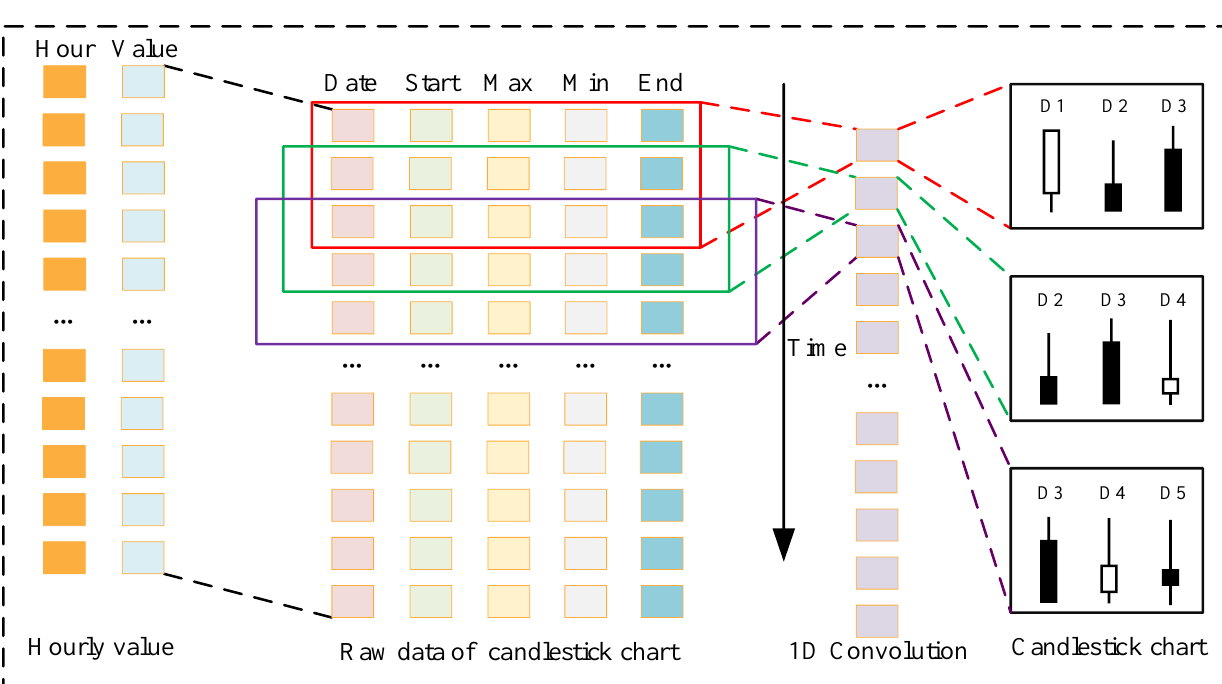
Figure 3. Principle of the candlestick chart generator.